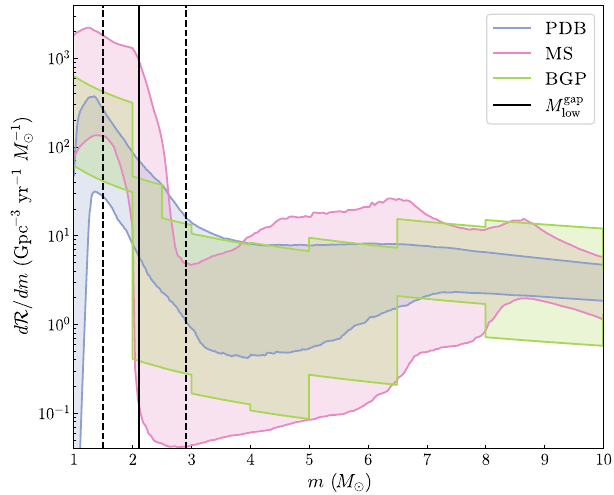
FIG. 5. Differential merger rate as a function of component mass for the PDB, MS, and BGP models. Three independent methods with different modeling assumptions agree on the merger rate versus mass, while illustrating the importance of modeling systematics on the overall rate for objects with NS- scale masses. Shaded areas denote 90% credible regions, while vertical black lines denote the median (solid) and 90% credible intervals (dashed) of the lower boundary of the mass gap M gap the PDB model rate dropoff